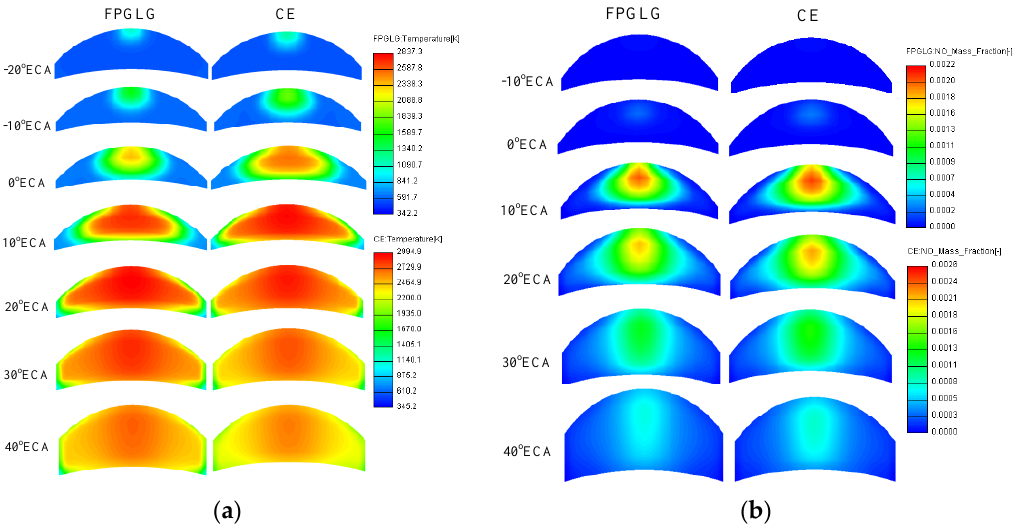
Figure 15. ( a ) Comparison of the temperature field; ( b ) comparison of the NO formation field.